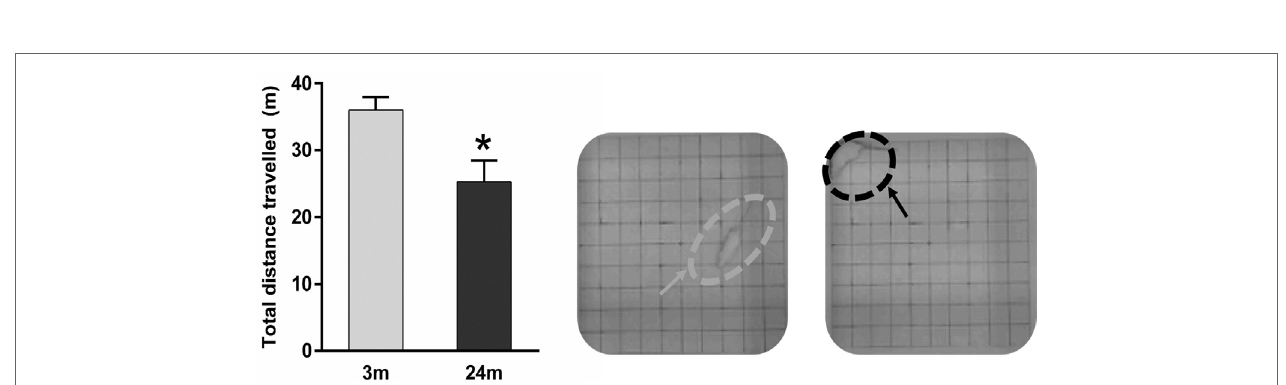
FigUre 3 | Mean ± seM (meter) total distance traveled in the open field . Asterisk denotes p < 0.05 (Mann–Whitney U test) showing 24-month-old rats ( n = 5) traveling a significantly shorter distance vs. 3-month-old rats ( n = 4). Example representative images of an adult rat exploring the open-field (gray arrow) and an aged rat crouched in the open-field corner (black arrow).